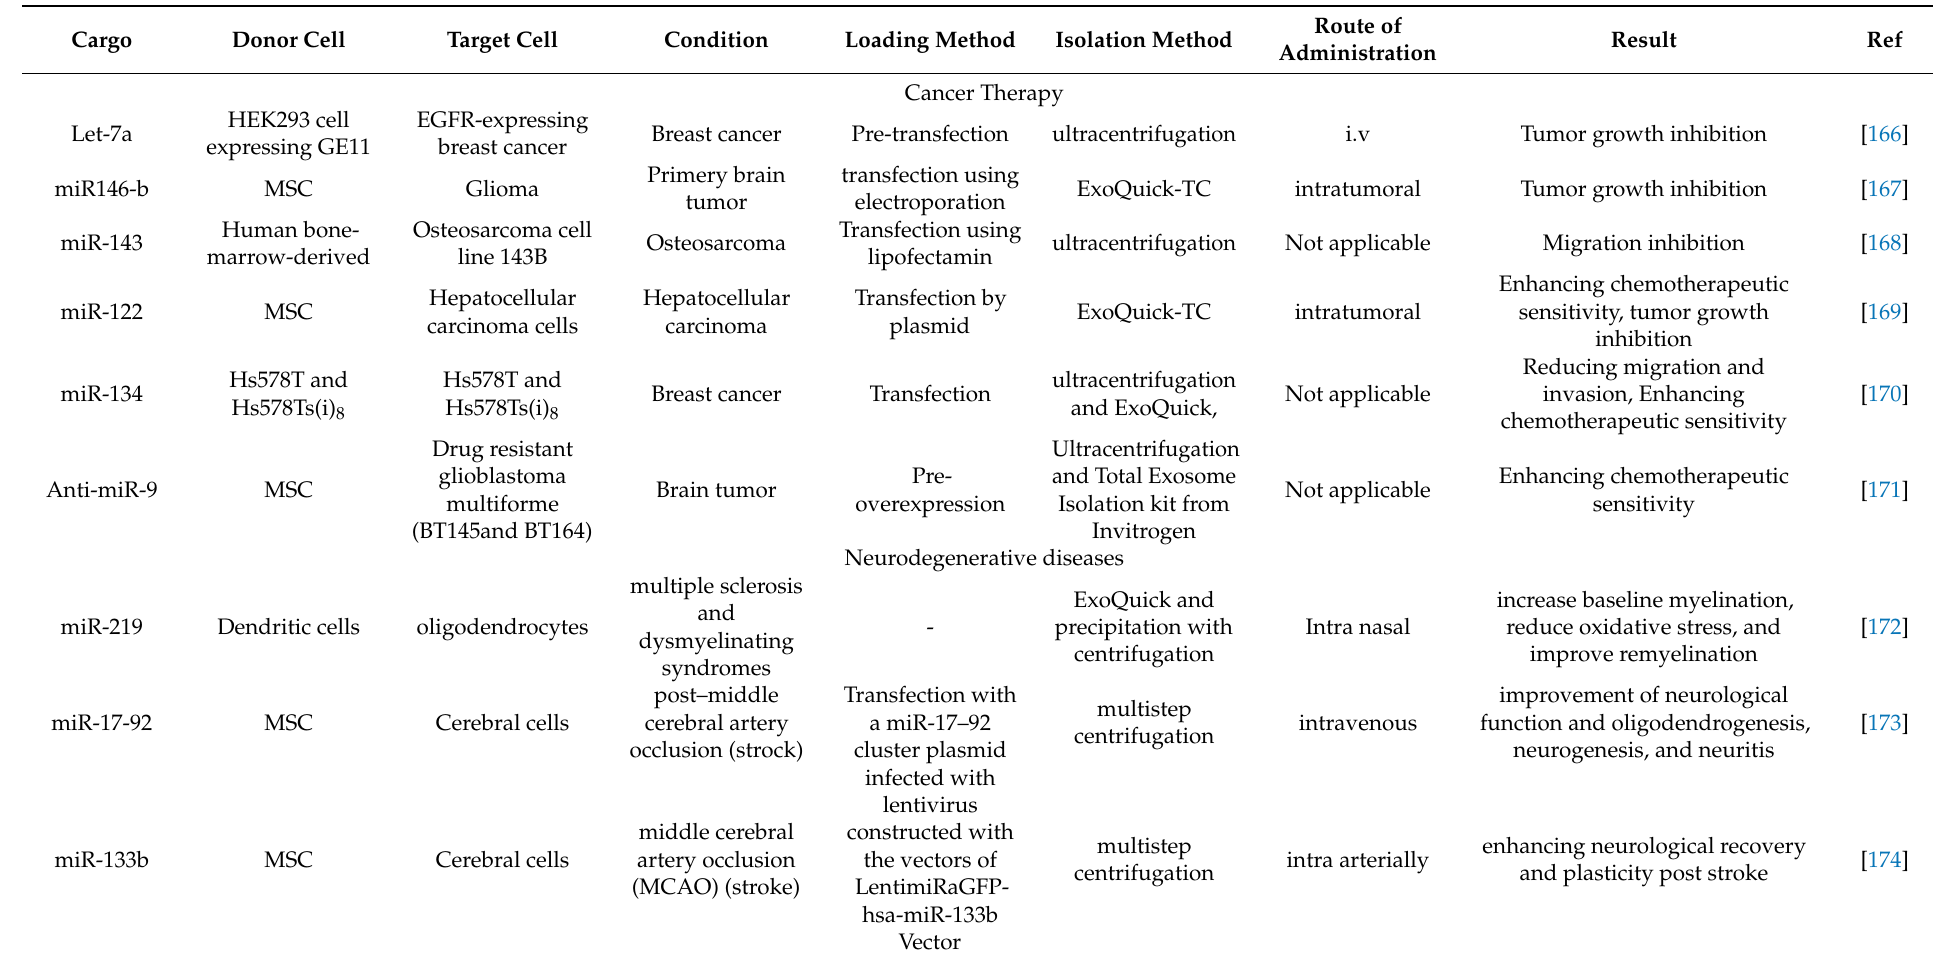
Table 2. Therapy based on miRNA-loaded